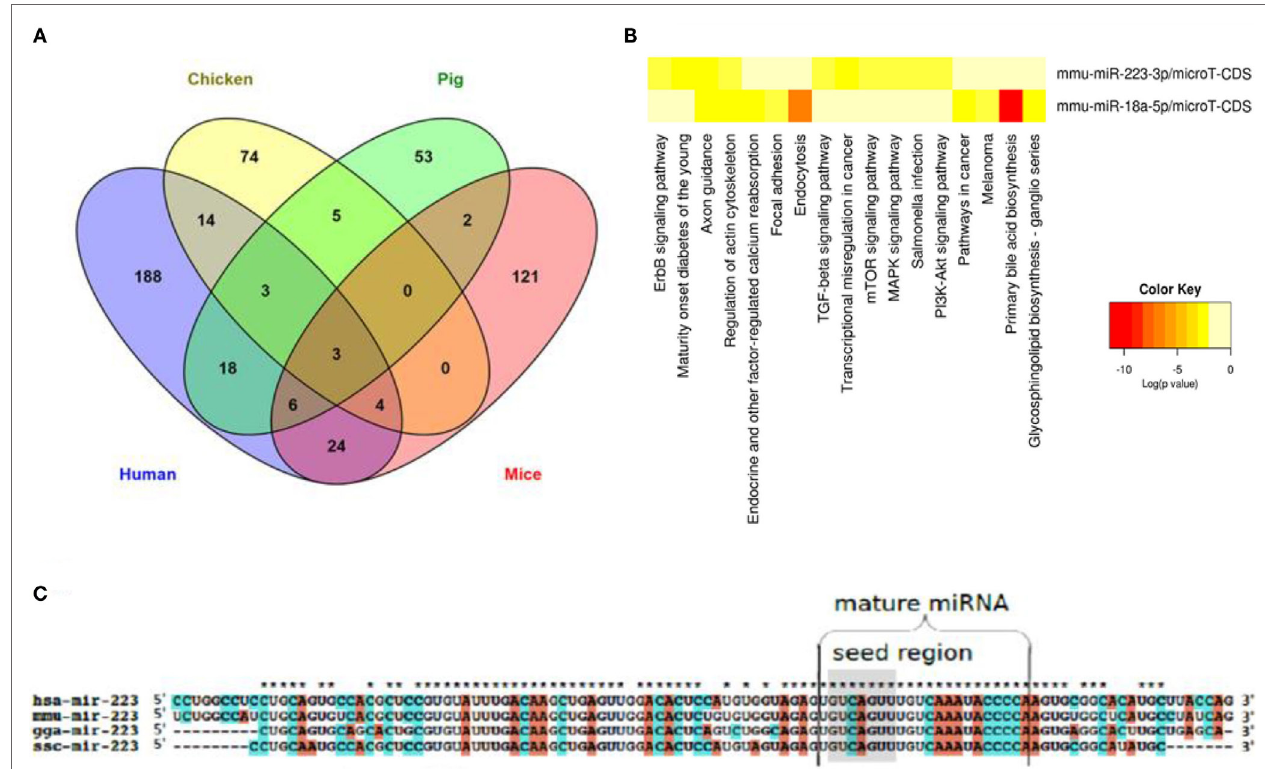
FiGURe 3 | miRNAs that are regulated in iAv infection in humans, chicken, pig, and mice . (A) Venn diagram depicting miRNAs that are differentially and commonly expressed in the four species. (B) Heat map showing the pathways regulated by two of the three miRNAs regulated in all four species. (C) Sequence alignment of the premature form of miR-223, a well characterized miRNA that is regulated in all four species. While the mature form of this miRNA is highly conserved across the four species (represented by stars above the sequences), the premature form shows a lesser degree of conservation. The seed region is highlighted in